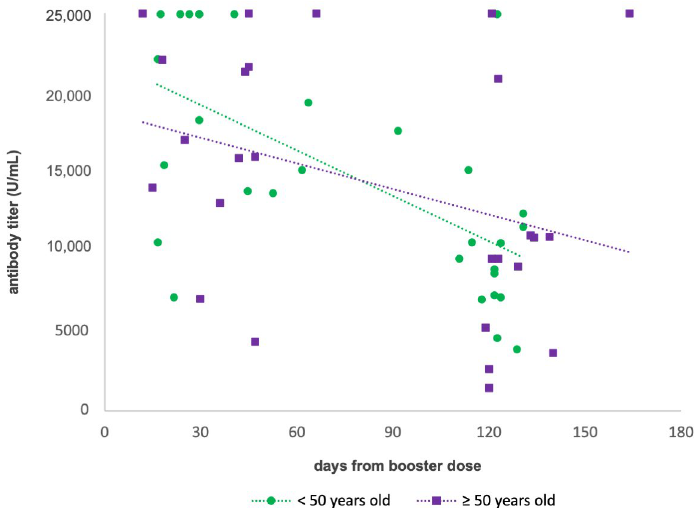
Figure 4. Scatter diagram showing the antibody titer (detection limits 0.4–25,000 U/mL) after the booster dose of <50 years old and ≥50 years old subjects against time and related regression lines.